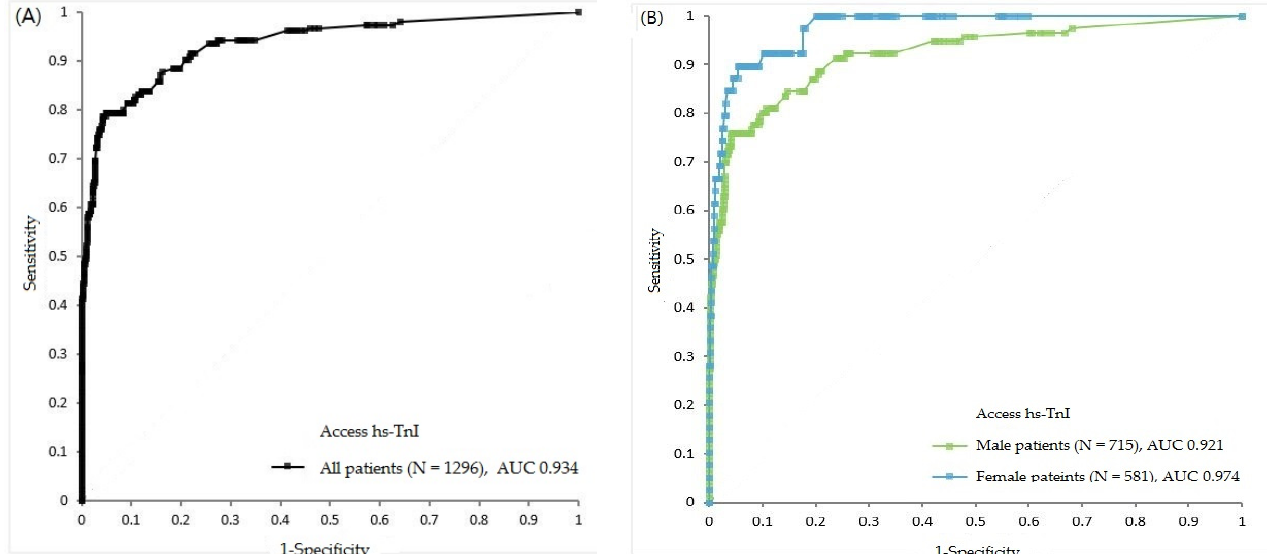
Figure 3. Receiver operating characteristic curves presenting diagnostic performance of Access hs-TnI assay at presentation for the diagnosis of AMI in all patients ( A ) and in each gender: men and women ( B ). Table 2. Diagnostic performance of baseline Access hs-TnI using various cut-offs for AMI diagnosis.